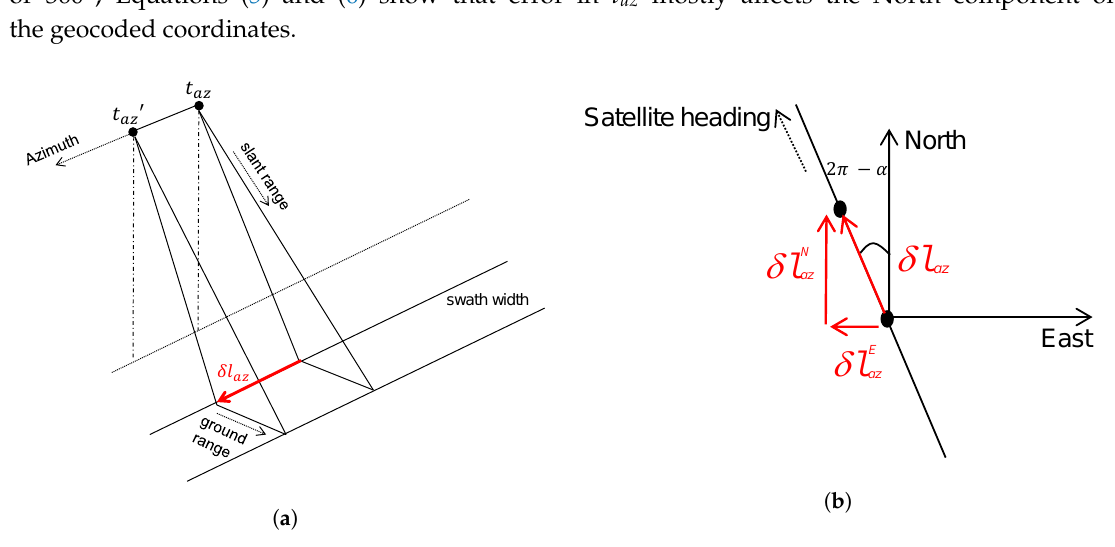
Figure 1. Timing bias in azimuth and its effect on the geocoded coordinates. ( a ) azimuth timing error causing a displacement on the ground δ l az ; ( b ) projection of δ l az onto the East δ l E az and North δ l N az components using satellite heading angle α